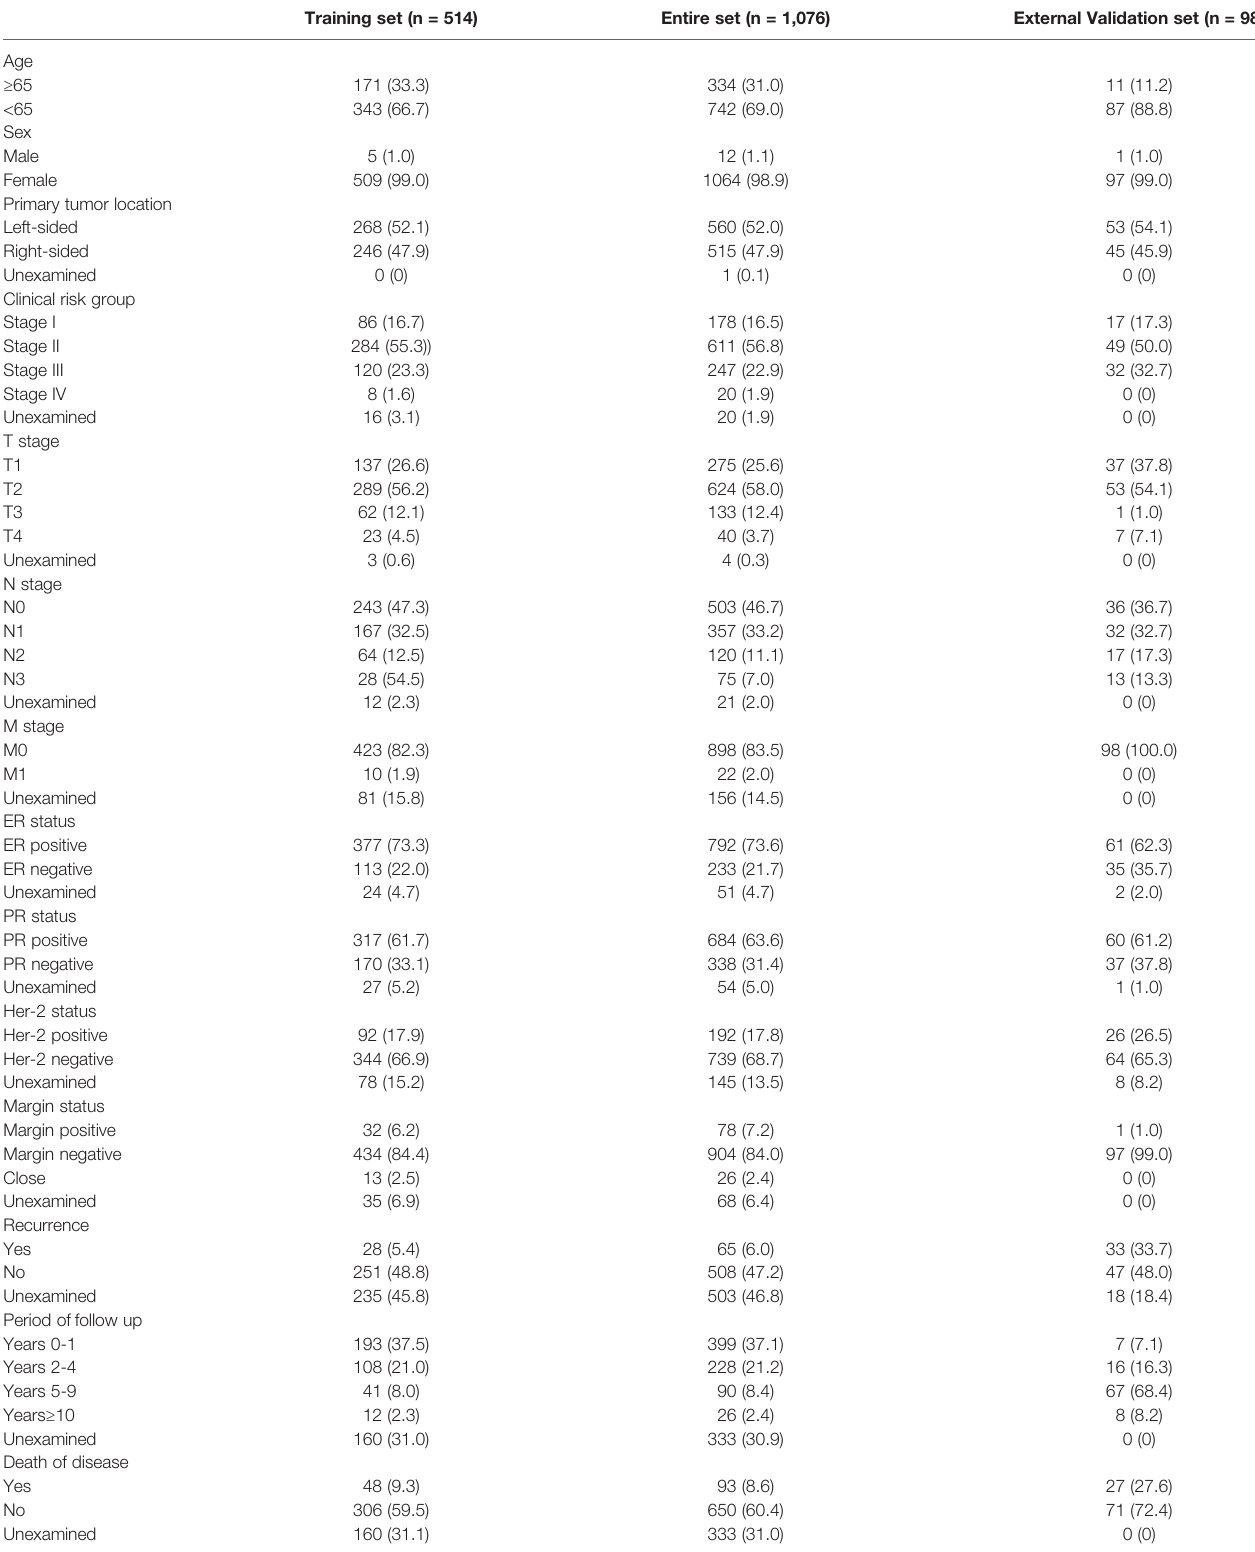
TABLE 1 | Clinical characteristics of patients with breast cancer involved in this